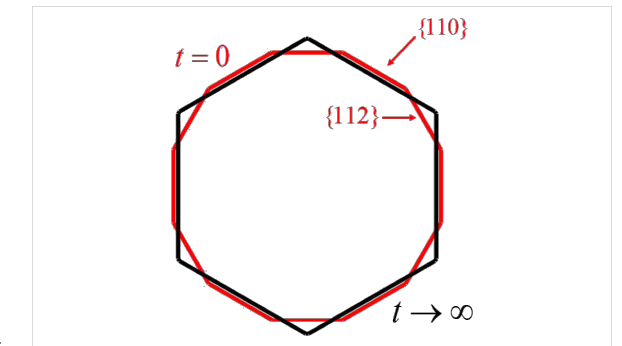
Figure 3: Evolution of a dodecagonal crystal (bounded by red lines) to a hexagonal crystal (bounded by black lines) due to surface diffusion.